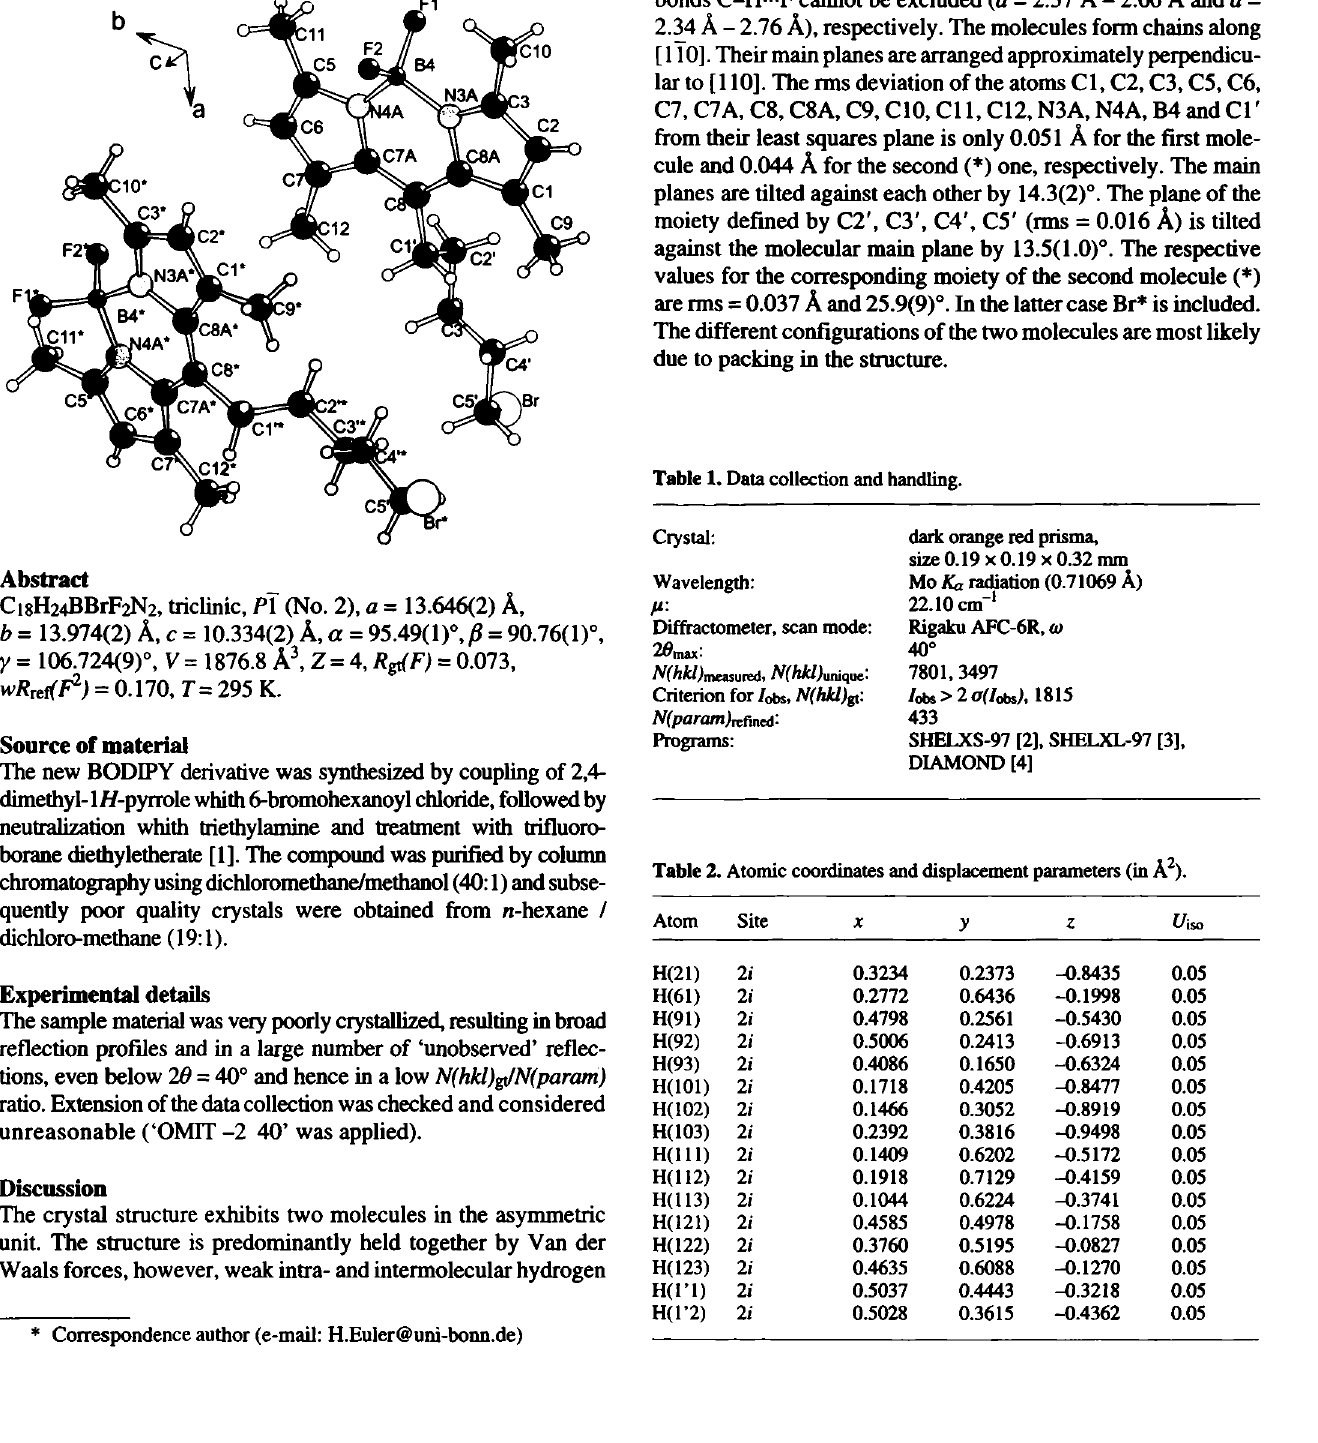
Table 2. Atomic coordinates and displacement parameters (in Â 2